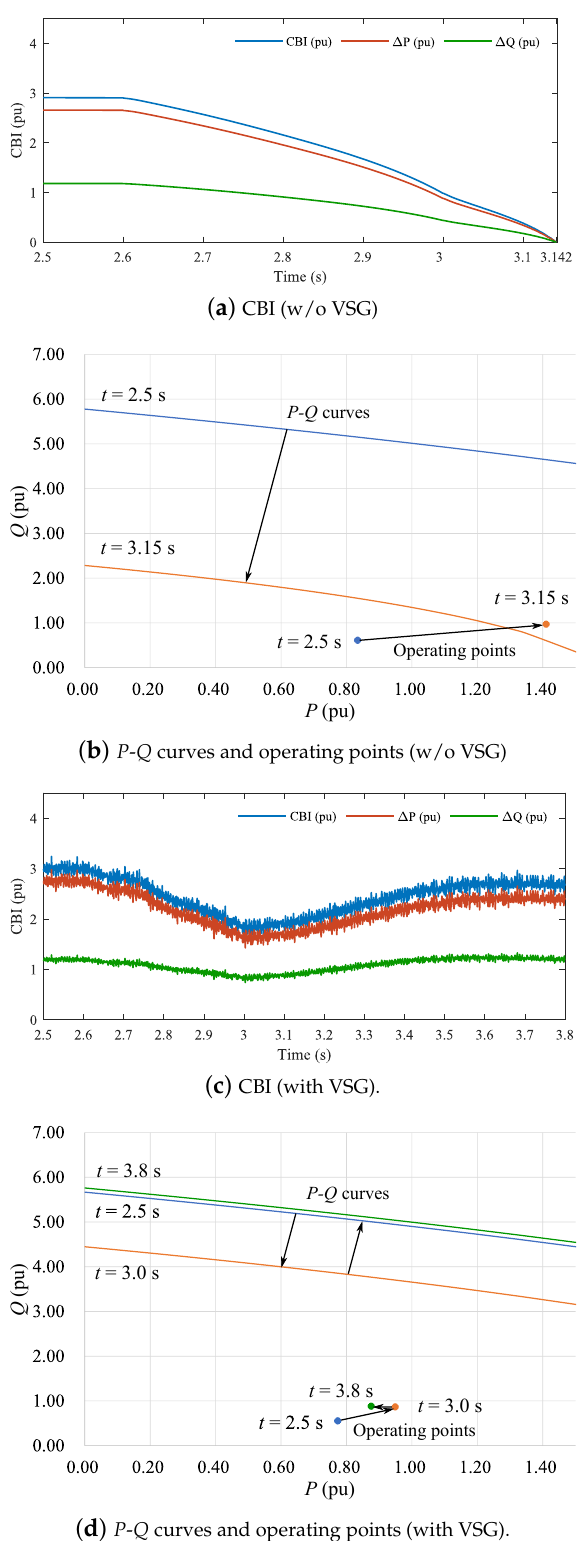
Figure 14. Critical boundary index (CBI) in Case 1.1 with/without